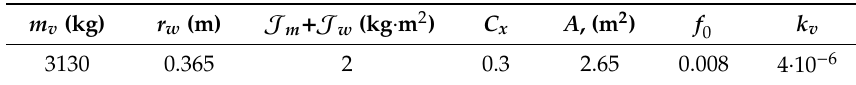
Table 1. Parameters for the model of vehicle